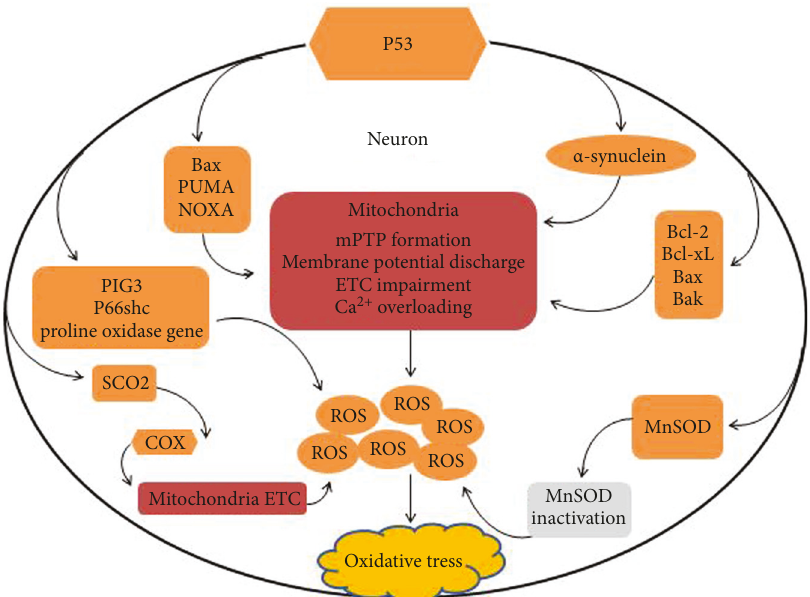
Figure 1: p53 activation in ROS production under irreversible stress conditions. p53 regulates cellular redox homeostasis through transcriptional action and modified expression of pro-oxidant and antioxidant proteins. p53 activation induces the expression of many proapoptotic proteins, such as Bax, PUMA, and NOXA, and facilitates Bax/Bak-mediated permeabilization of the outer mitochondrial membrane leading to the discharge of the membrane potential and ETC impairment followed by excessive ROS production. p53 also activates pro-oxidative genes including PIG3, proline oxidase, and p66shc to induce elevated levels of oxidative stress. The pro-oxidative activities of p53 also include the activation of expression of SCO2 gene, which is essential for regulating COX complex, the major site of oxygen utilization in the eukaryotic cells. The accumulation of cytosolic p53 protects α -synuclein from ubiquitin-mediated degradation inducing ROS generation and oxidative stress. α -Synuclein, in respone to cellular stress specifically targets mitochondria causing their profound alterations, including collapse of transmembrane potential, impairment of respiratory chain complexes, disturbance of mito- chondrial Ca 2+ homeostasis, and subsequent excessive ROS production. Accumulation of p53 in the mitochondrial matrix also contributes to oxidative damage to target cells by binding and inactivating the antioxidant